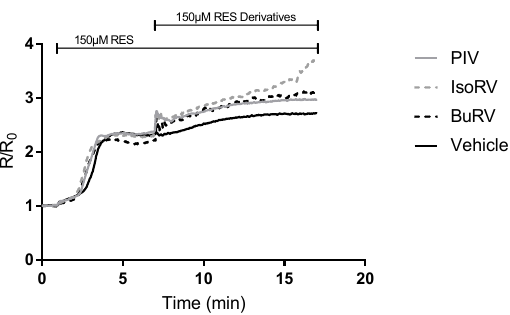
Figure 6. RES and RES derivatives activate the same calcium source(s) to increase [Ca 2+ ] i . Fura-2-loaded MDA-MB-231 cells were treated with RES at 1 min and then with PIV (gray, solid), IsoRV (dash, gray), BuRV (dash, black), or a vehicle (black, solid) at 7 min. Each time trace is the average of three biologic replicates.